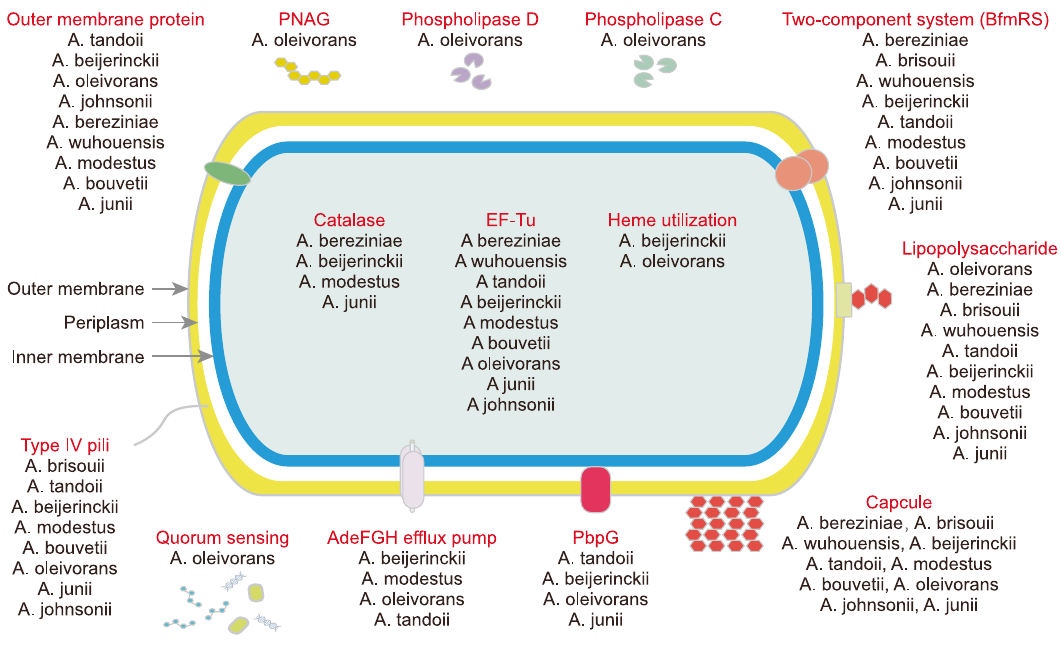
Fig. 5 Potential virulence factors in Acinetobacter